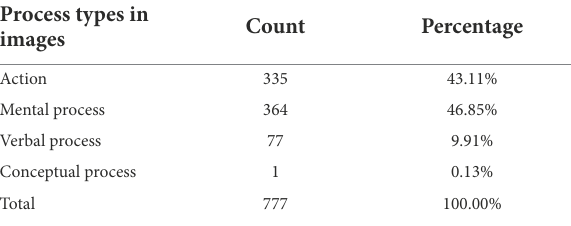
TABLE 3 Distribution of different processes in